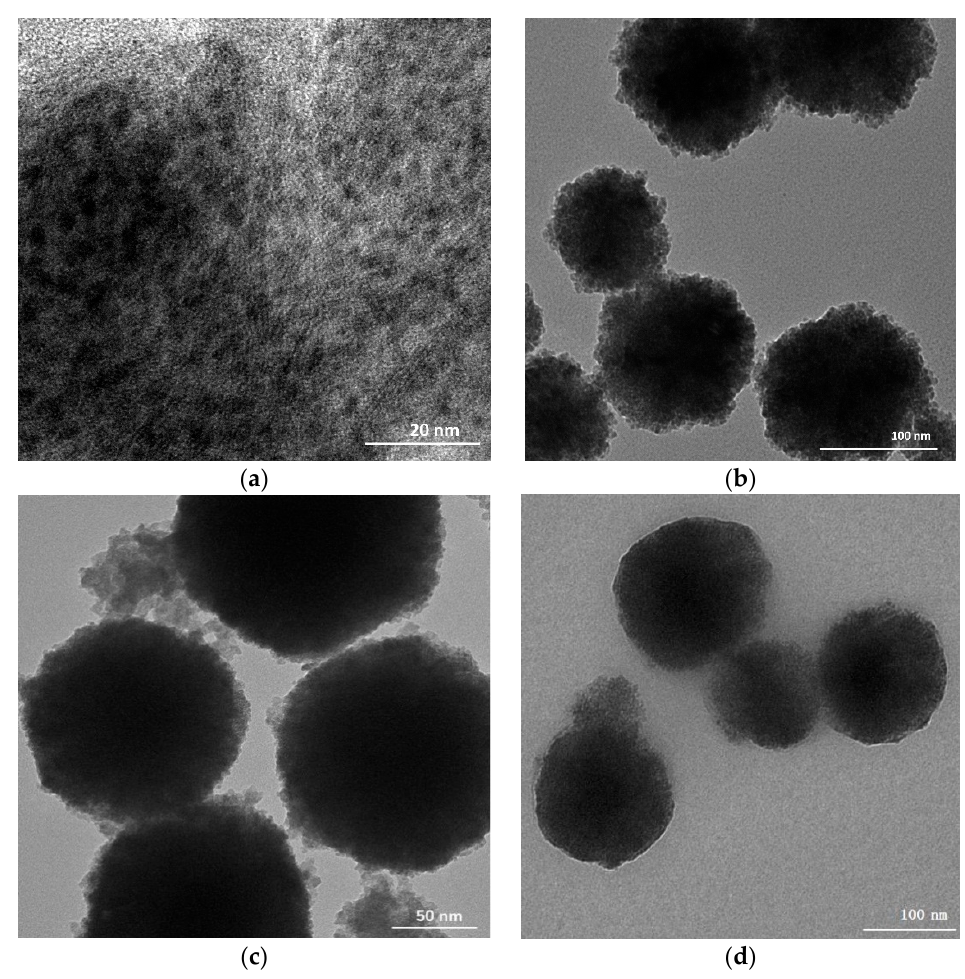
Figure 2. TEM images of ( a ) Mn 2+ : ZnS QDs, ( b ) MNP, ( c ) MNP/QDs and ( d ) MNP/QD@MIPs. The XRD pattern of MNP/QD NCs (Figure S2) showed typically characteristic diffrac- tion peaks at 2 θ values of 30.0 ◦ , 35.64 ◦ , 43.10 ◦ , 57.10 ◦ , and 62.82 ◦ , corresponding to the (220), (311), (400), (440), (511) planes in the standard XRD data for Fe 3 O 4 (JCPDS No. 19-0629). Moreover, the characteristic diffraction peaks at 2 θ values of 28.80 ◦ , 48.80 ◦ , and 56.10 ◦ for MNP/QD NCs corresponded to the (111), (220), and (311) planes of the cubic ZnS (JCPDS No. 12-0688). The XRD pattern indicates the successful formation of Fe 3 O 4 @ZnS by the combination of Mn 2+ : ZnS QDs and Fe 3 O 4 MNPs. As shown in Figure S3, a clear